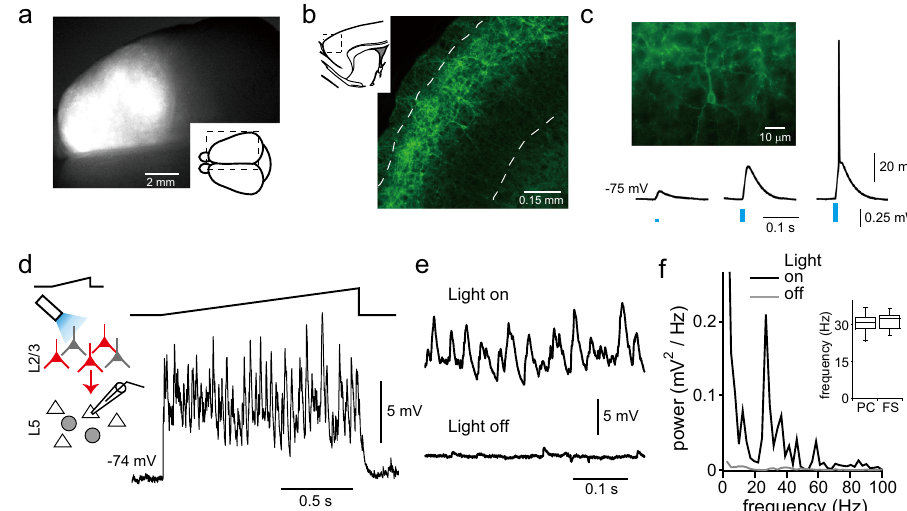
Fig. 1 Photostimulation-induced oscillations in L5 cells. a Low-magni fi cation view of a rat brain expressing mCherry and ChR2-Venus by in utero electroporation at E17.5. b Sagittal section of frontal cortex. ChR2-Venus was selectively expressed in L2/3 PCs. Dashed lines indicate the boarder of L1/L2, and L2/3/L5. Inset, schematic view of whole ( a ) and sagittal section ( b ) of the brain; dashed rectangles correspond to the images. c Responses to brief light illumination (5 ms in duration; 3 intensities) in a ChR2 positive L2/3 PC. d Oscillatory membrane potentials of a L5 PC in response to ramp-shaped light stimulation to L2/3. Inset, schematic drawing of experiment in the slice preparation. Triangle and gray circle indicate L5 PCs and FS cells. respectively. Red and gray cells in L2/3 indicate ChR2 positive and negative L2/3 PCs, respectively. Ramp shape line indicates intensity change of light stimulation. e Magni fi ed trace of membrane potentials of the cell shown in ( d ) during stimulation (upper) and no stimulation (lower). f Power spectra of membrane potentials. Inset, box plots of peak frequencies around 25 – 45 Hz induced by light stimulation in L5 PCs and FS cells ( n = 60 and 42,